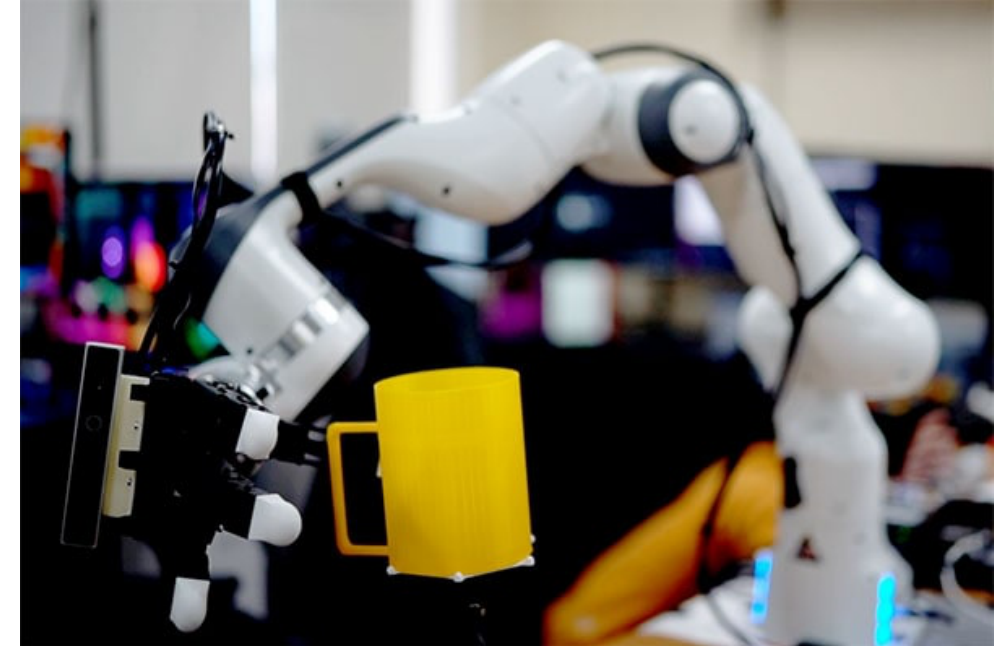
Figure 1. Hardware